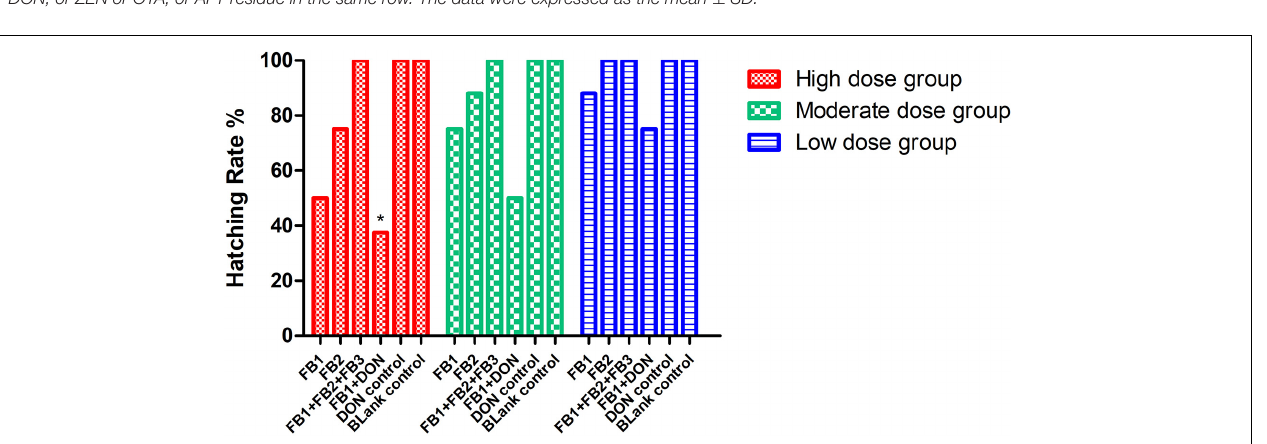
FIGURE 1 | Hatching rate post-inoculation with serial concentrations of FB or DON, or synergetic inoculation. *Indicates p < 0.05 when the high FB 1 + DON group was compared to the high FB 1 group, the high FB 1 + FB 2 + FB 3 group, and the DON group ( p = 0.037), while no significant difference was found when the moderate FB 1 + DON group was compared to other moderate groups and the DON group ( p = 0.114). Similarly, no statistical difference was found when the low FB 1 + DON group was compared to other low groups ( p = 0.427). The data were analyzed by Chi-square test with SPSS as the categorical